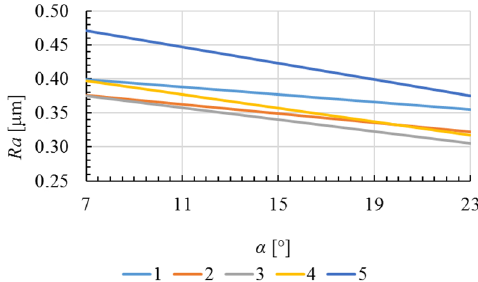
Figure 13. Effect of the curvature radius ρ 1 on the Ra roughness parameter in the machining of the concave surface: (1) α = 7 ◦ , (2) α = 11 ◦ , (3) α = 15 ◦ , (4) α = 19 ◦ , (5) α = 23 ◦ .